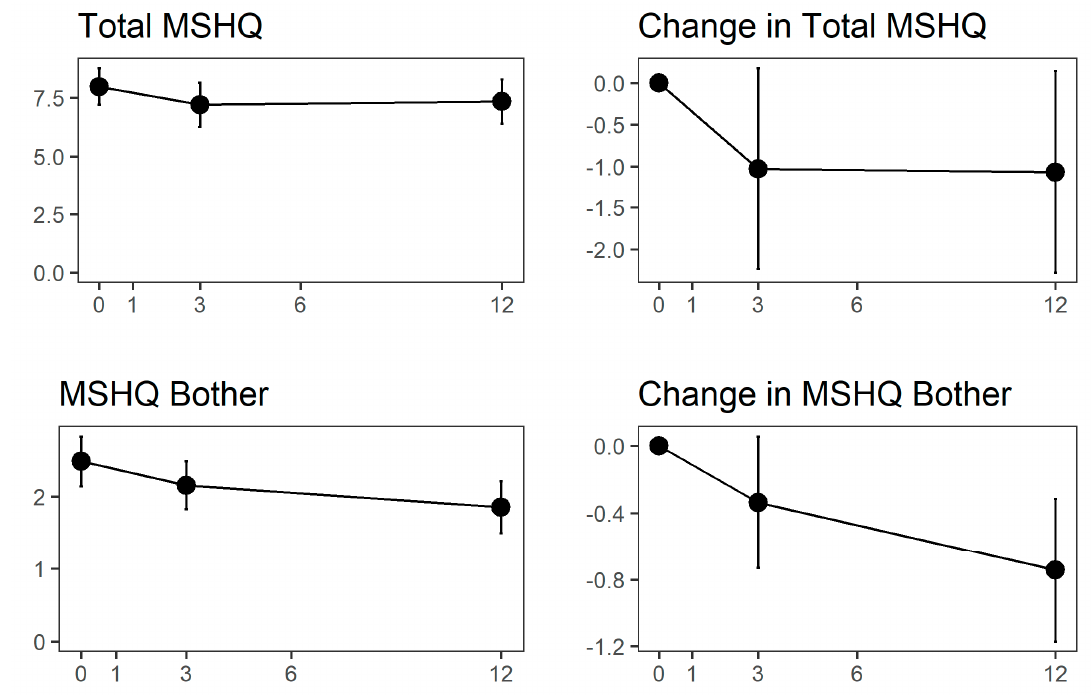
Figure 3. Absolute (y-axis) and change (y-axis) in ejaculatory function as measured by Men’s Sexual Health Questionnaire (MSHQ-EjD) scores. Population means are shown at the left; changes from baseline are shown at the right. Months after Aquablation procedure is the y-axis in all graphs.